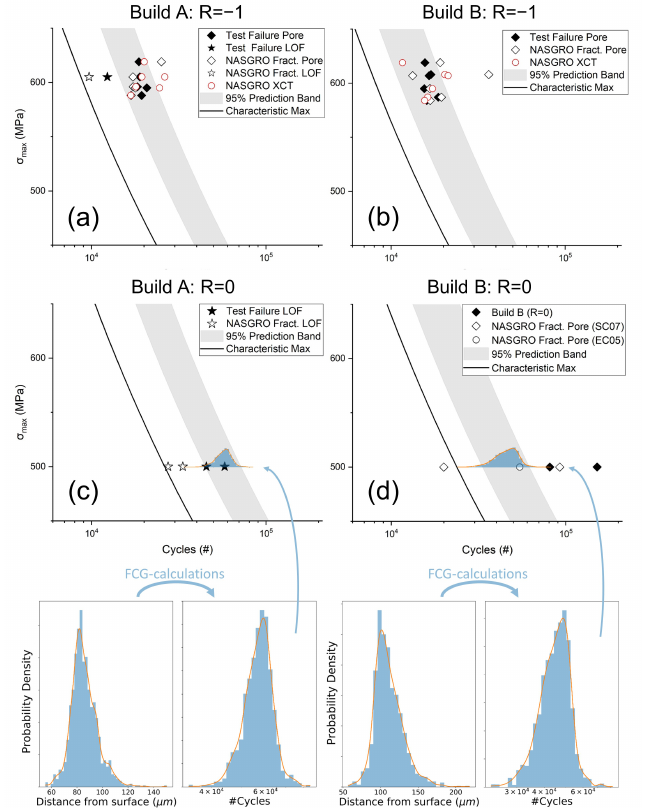
Figure 10. Experimental fatigue data (solid markers) and modelled life predictions (hollow markers and bands). ( a ) Build A, R = − 1. ( b ) Build B, R = − 1. ( c ) Build A, R = 0. ( d ) Build B, R = 0. Histograms show the distributions of the distance of simulated defects to the specimen surface and the distributions of calculated life. FCG, fatigue crack